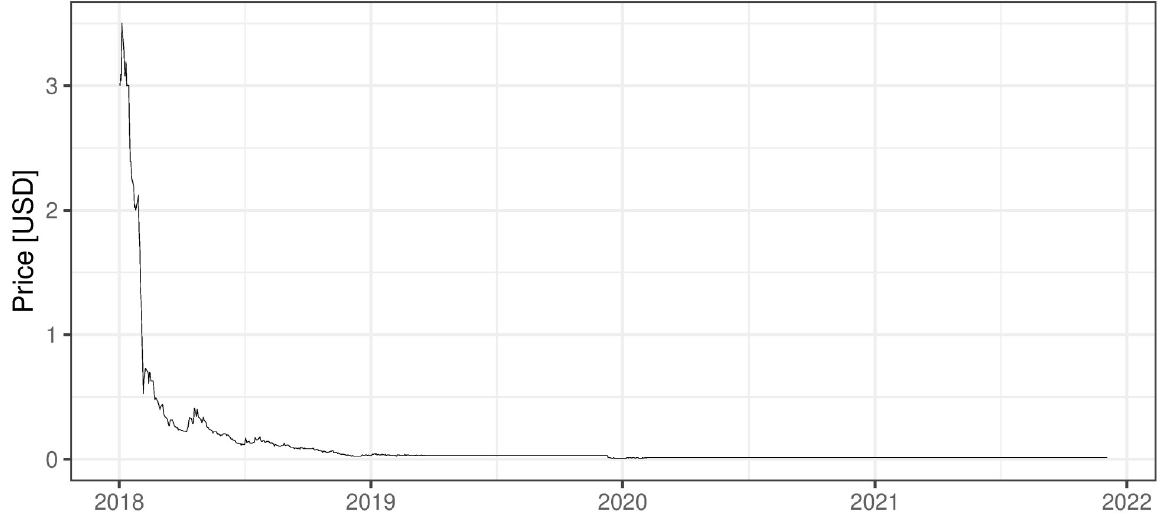
Fig 3. The daily fluctuations of HashChain Technology prices on TSE. Source: https://ih.advfn.com/stock-market/TSXV/KASH/historical/ more-historical-data (downloaded on 2021/13/03).